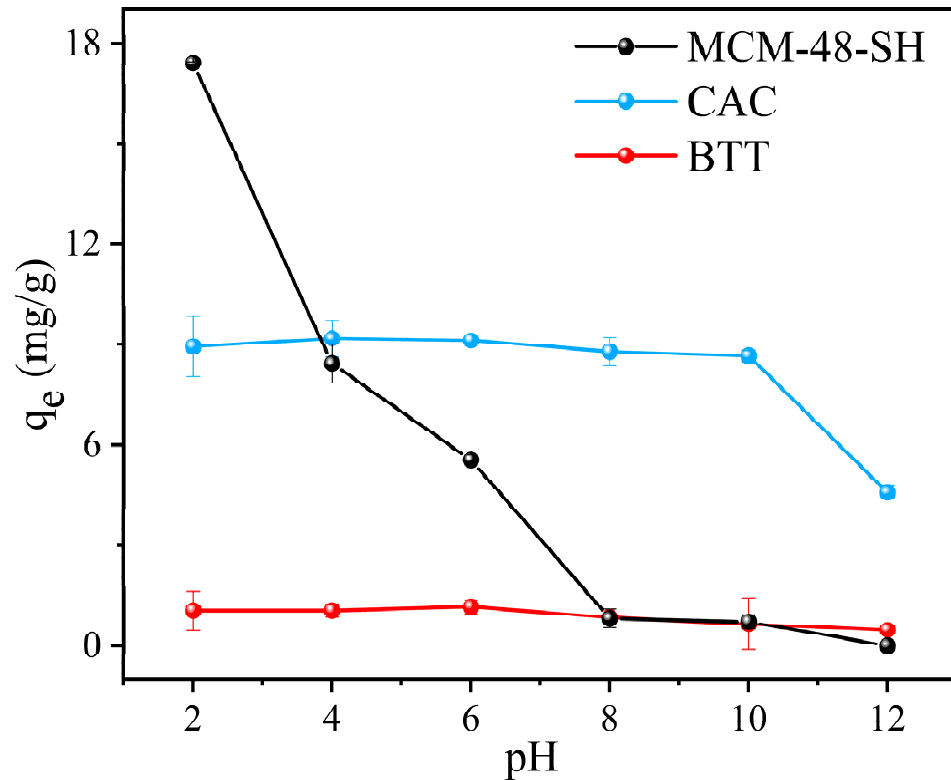
Figure 12. Adsorption effect diagram of the three adsorbents at different solution pHs (the reaction temperature was 25 ◦ C, the amount of adsorbent was 25 mg, and the reaction time was 3